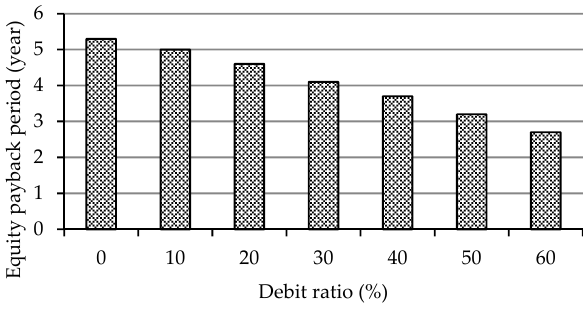
Figure 16. Effect of incentives on payback period.